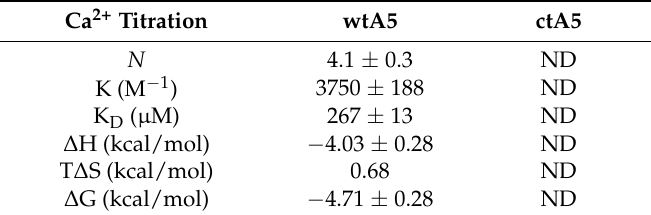
Table 1. Parametric analysis of calcium titration.